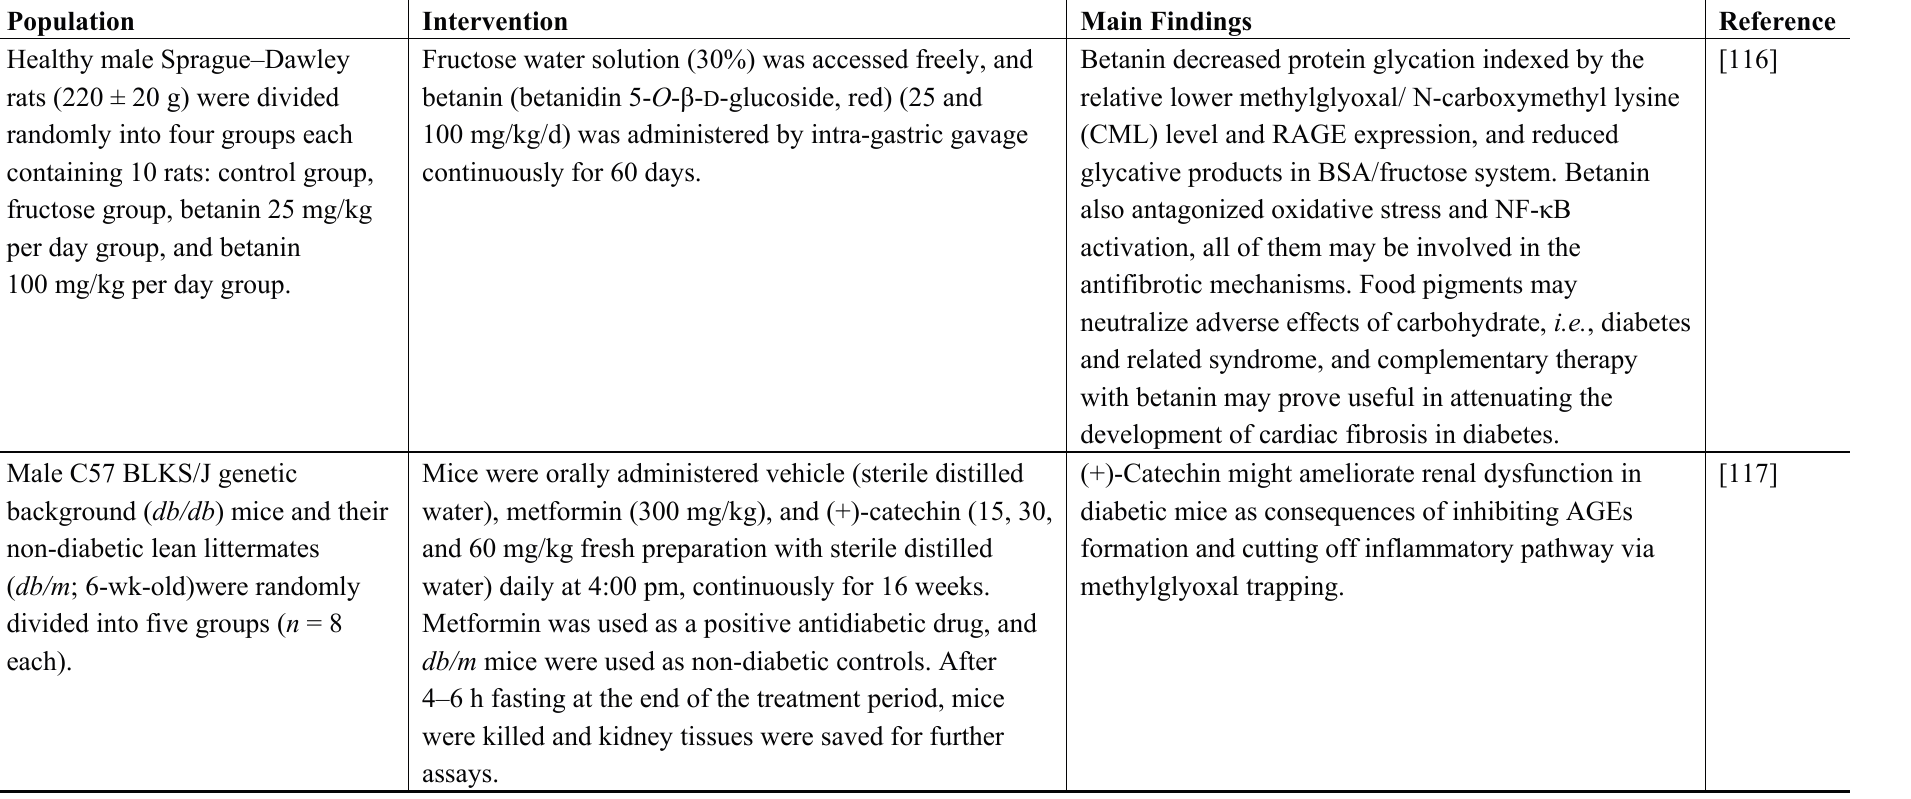
Table 1. Results of chosen in vivo studies of the effects of natural compounds on